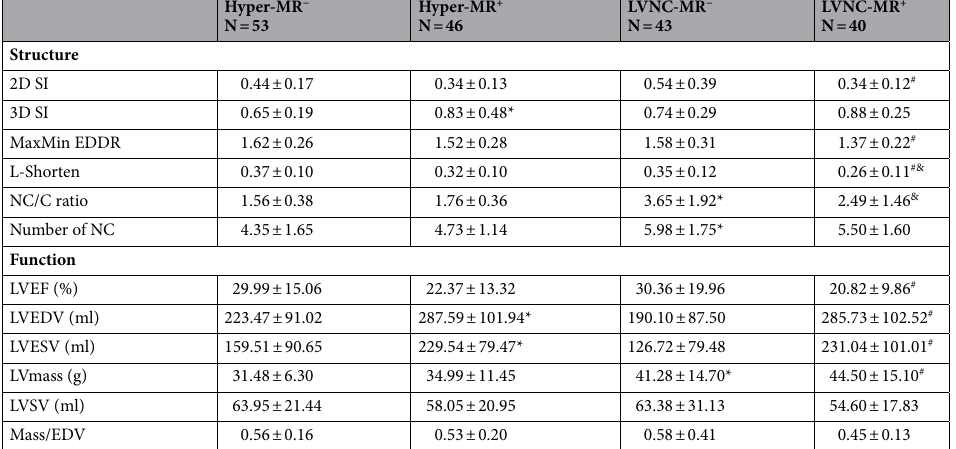
Table 2. The cardiac structure and function. *vs Hyper-MR − , & vs Hyper-MR + , # vs LVNC-MR − . Hyper-MR − hypertrabeculation patients without mitral regurgitation, Hyper-MR + hypertrabeculation patients with mitral regurgitation, LVNC-MR − LVNC patients without mitral regurgitation, LVNC-MR + LVNC patients with mitral regurgitation, LVNC left ventricle non-compaction, 2D SI two-dimensional sphericity index, 3D SI three- dimensional sphericity index, MaxMin EDDR maximum/minimum end-diastolic ratio, L-shorten longitudinal shortening, NC/C non-compacted to compacted myocardium, LVEF left ventricular ejection fraction, LVEDV left ventricular end-diastolic volume, LVESV left ventricular end-systolic volume, LVSV left ventricular stroke volume.